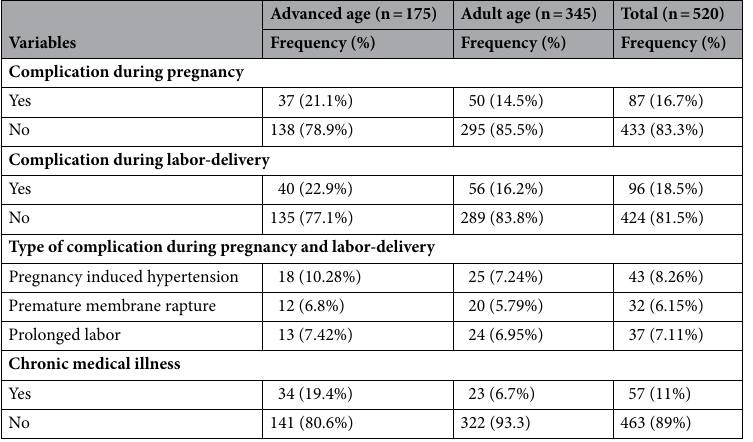
Table 3. Obstetrics and medical characteristics of mothers who gave birth in Awi Zone Public Hospitals, Ethiopia, 2020.